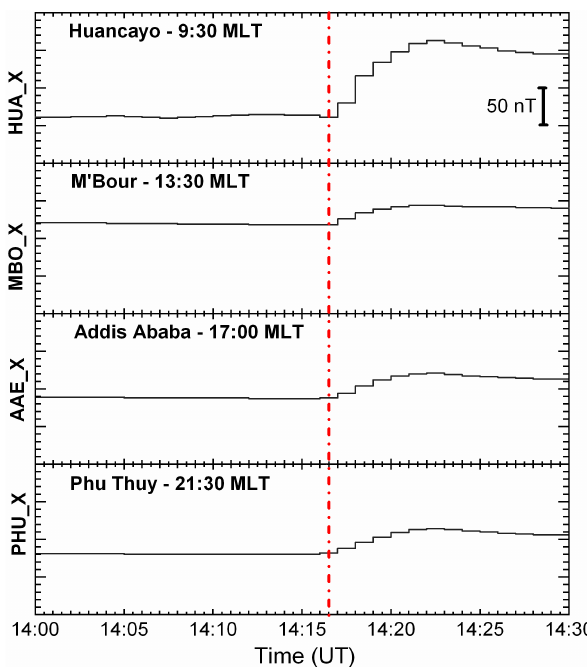
Fig. 3. Horizontal component ( X ) of magnetograms from ground- based stations close to the geomagnetic equator, in increasing order of MLT from top to bottom, on 6 January 1998 between 14:00 and